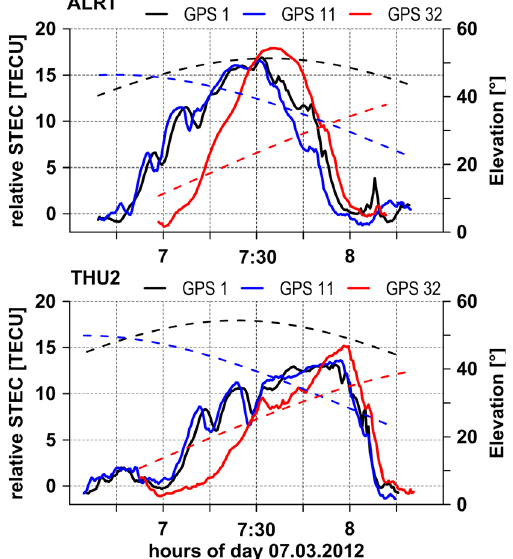
Fig. 3. Signatures of TOI observed for satellites at different eleva- tions: station ALRT (top panel) and station THU2 (bottom